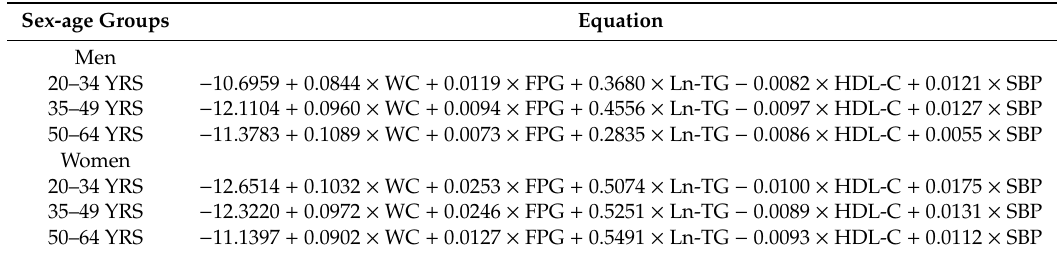
Table 3. Equations used to calculate sex- and age-specific metabolic syndrome severity scores Sex-age Groups Equation